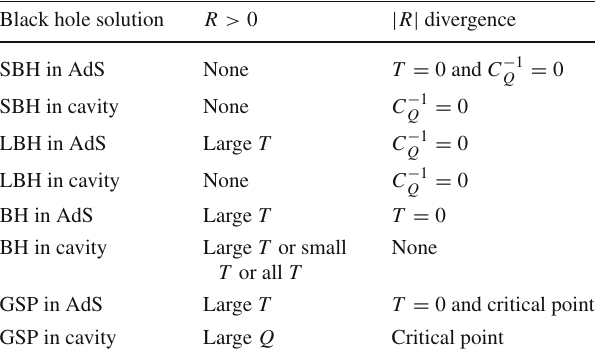
Fig. 9 Phase structure of a RN black hole in a cavity in the (cid:2) - T dia- gram. The saturated Small BH (blue line) and Large BH (red line) are separated by the critical point (black dot). For a fixed value of (cid:2) , there exist two black hole solutions, which are displayed in the left and right frames, respectively. The pink region is the coexistence region of Small BH and Large BH, and R > 0 in the yellow region Table 1 The Ruppeiner invariant R for the black hole solutions in the AdS and cavity cases. Tabulated are the regions where R > 0 and the possible divergences of R . BH denotes the single black hole solution when Q > Q c . GSP strands for “globally stable